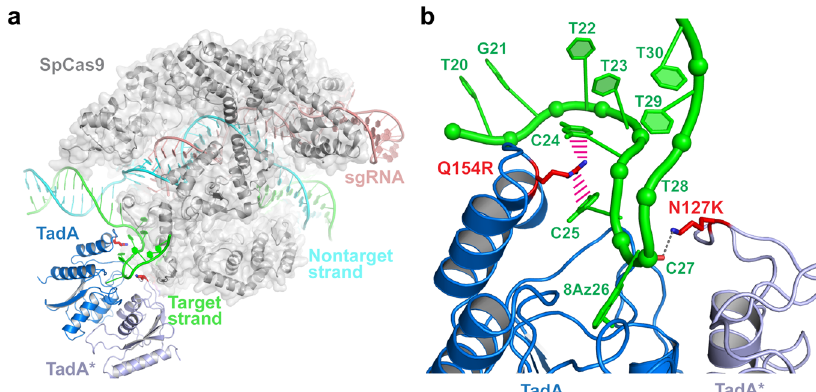
Fig. 5 Molecular basis of enhanced editing ef fi ciency of NG-ABEmax-KR. a Overall structural model of NG-ABEmax-KR showing SpCas9 (gray), target- strand DNA (TS, green), nontarget-strand DNA (NTS, cyan), single-target RNA (sgRNA, red), TadA (blue) and TadA* (light blue). The side chains of N127K of TadA* and Q154R of TadA are shown as red sticks. b Modelled interactions between the key residues of NG-ABEmax-KR with TS DNA, colored as in ( a